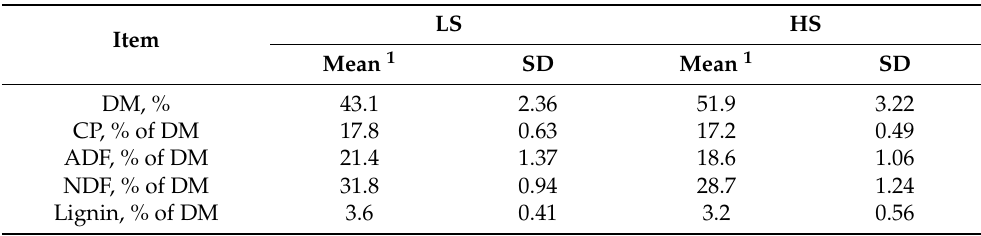
Table 2. Mean chemical composition and associated standard deviations for low-starch (LS) and high-starch (HS) diets fed to cows throughout the experimental